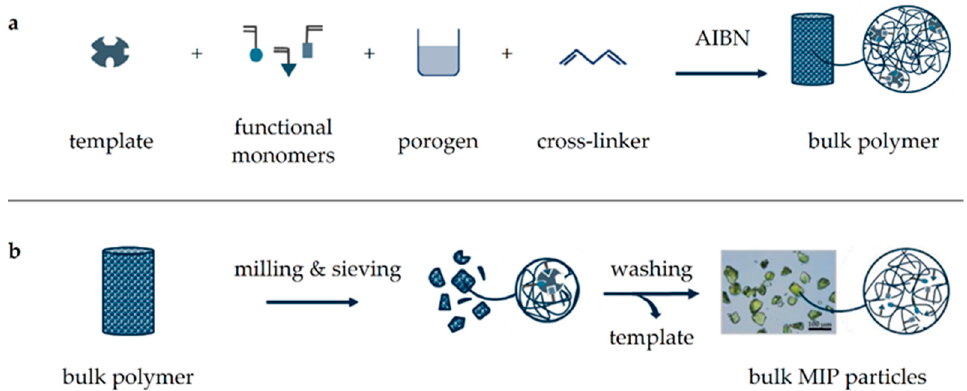
Figure 1. Schematic illustration of MIP synthesis by bulk polymerization. First, a template, functional monomers, cross-linker, and radical starter (AIBN) are dissolved in porogen followed by heat-induced polymerization ( a ). The resulting polymer block is crushed, milled, and sieved to obtain uniformly sized particles, which are washed thoroughly to remove the template ( b ).